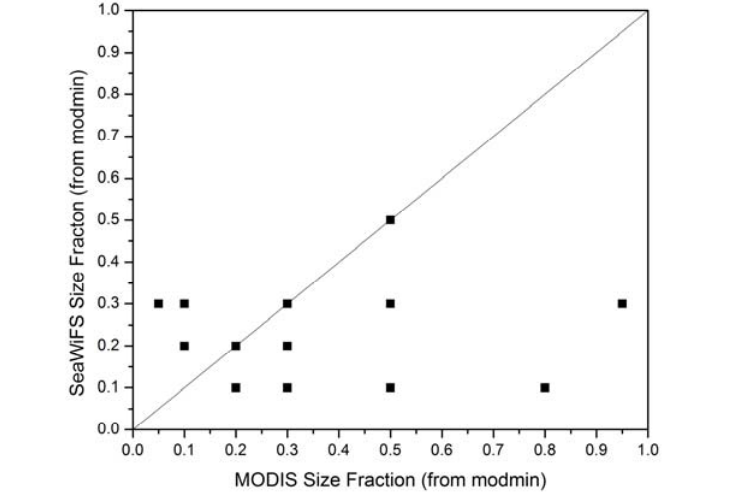
Figure 17. MODIS and SeaWiFS size fraction comparison (modmin from bounding aerosol model selection), Venice AERONET-OC location, 2010.